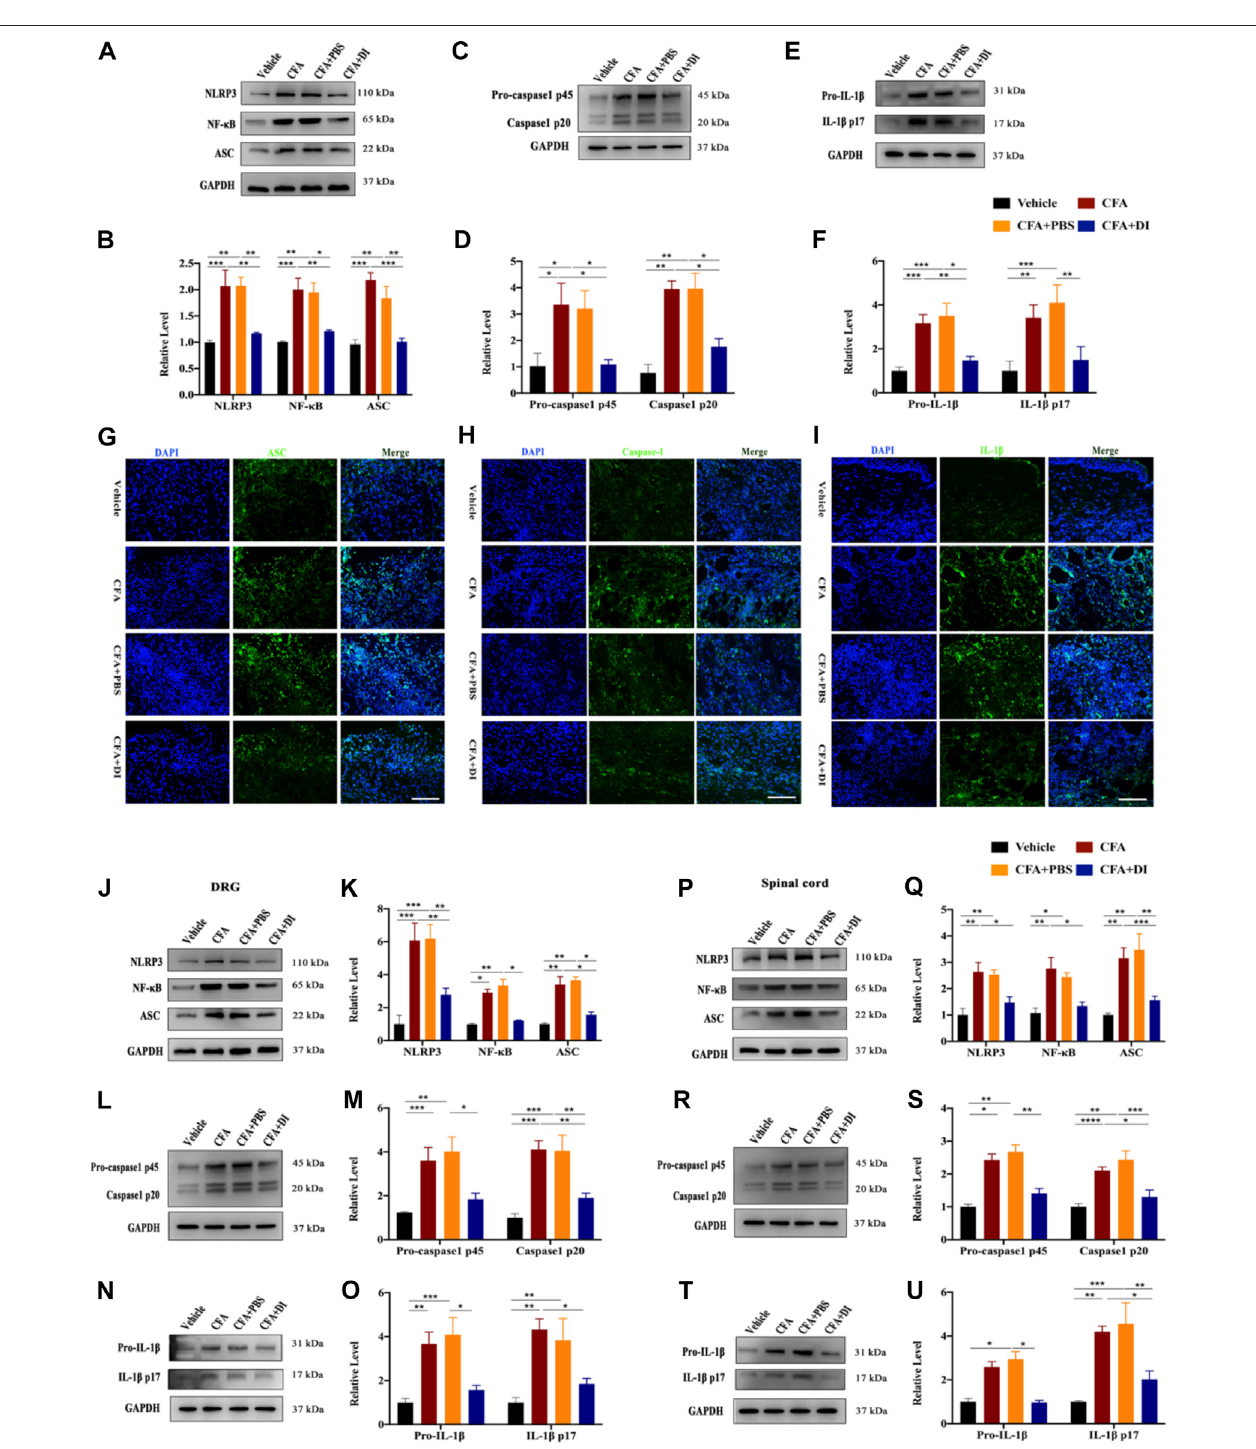
FIGURE 6 | DI inhibited NLRP3 in fl ammasome activation and IL-1 β secretion. (A,B) Western blotting bands and analysis of NLRP3, ASC, NF- κ B in plantar tissue. F group (3, 8) = 10.95 for NLRP3, F group (3, 8) = 18.02 for ASC, F group (3, 8) = 12.64 for NF- κ B. (C,D) Western blotting bands and analysis of Caspase1 p45 and p20 in plantar tissue.F group (3, 12)= 9.598for Caspase1 p45, F group (3, 12) =16.47 forCaspase1p20. (E,F) Western blottingbands and analysis ofpro-IL-1 β and IL-1 β p17 in plantartissue.F group (3,20)=11.32forpro-IL-1 β ,F group (3,20)=7.736forIL-1 β p17.Immuno fl uorescentstainingforASC(green) (G) ,Caspase-1(green) (H) ,IL-1 β (green) (I) , the nuclei were stained blue with DAPI. The scale bar indicates 50 μ m. (J,K) Western blotting bands and analysis of NLRP3, ASC, NF- κ B in DRG. F group (3, 16) = 11.44 for NLRP3, F group (3, 16) = 23.45 for ASC, F group (3, 16) = 29.99 for NF- κ B. (L,M) Western blotting bands and analysis of Caspase1 p45 and p20 in DRG.